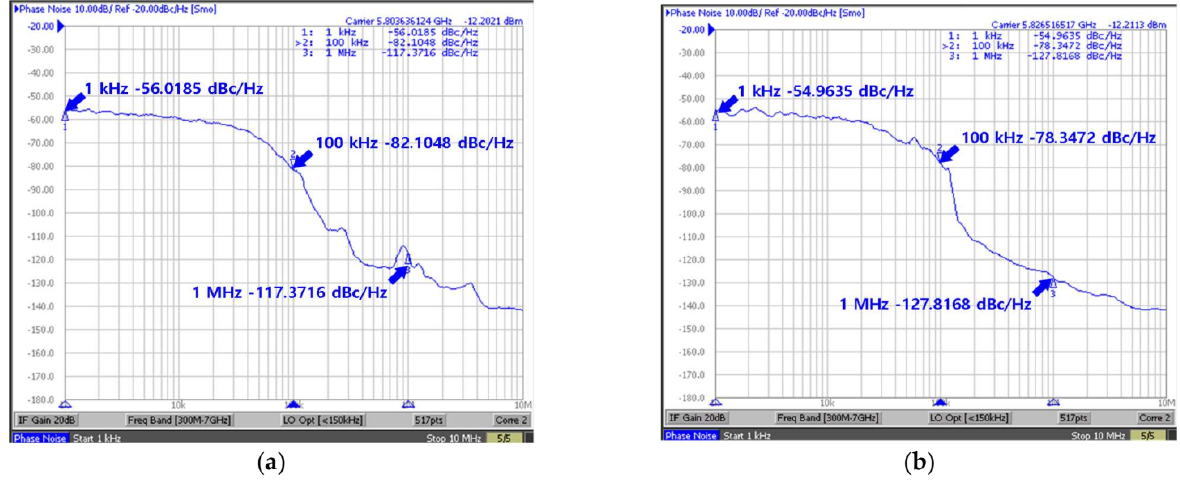
Figure 11. Output noise measurement result of the proposed VCO at 5.8 GHz ( a ) without switched dc-dc converter, and ( b ) with switched dc-dc converter.